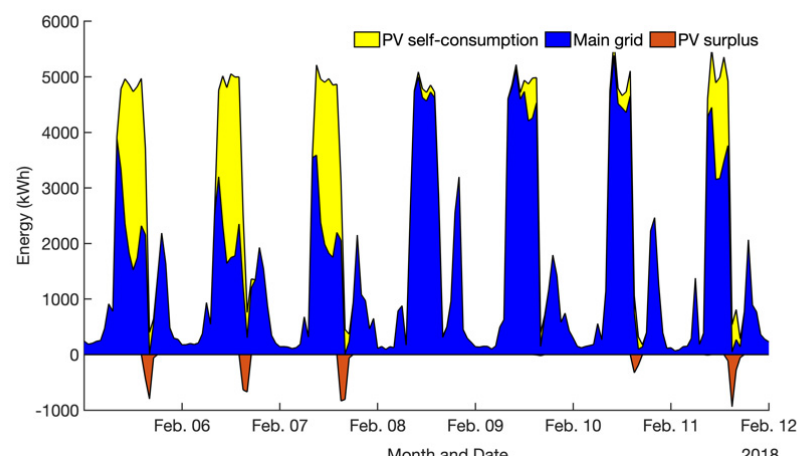
Figure 6. The daily operational profile of the ger with the ETS heater and solar PV for one week. The yellow color indicates the amount of electricity consumed in the ger from the PV system. The blue color indicates the amount of electricity consumed in the ger from the main grid. The orange color is the electricity flow from the PV system to the main grid.